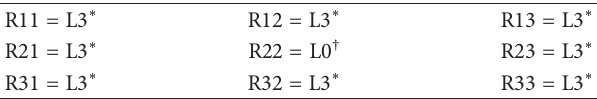
Table 2: The signal level matrix of a tag located in the area of